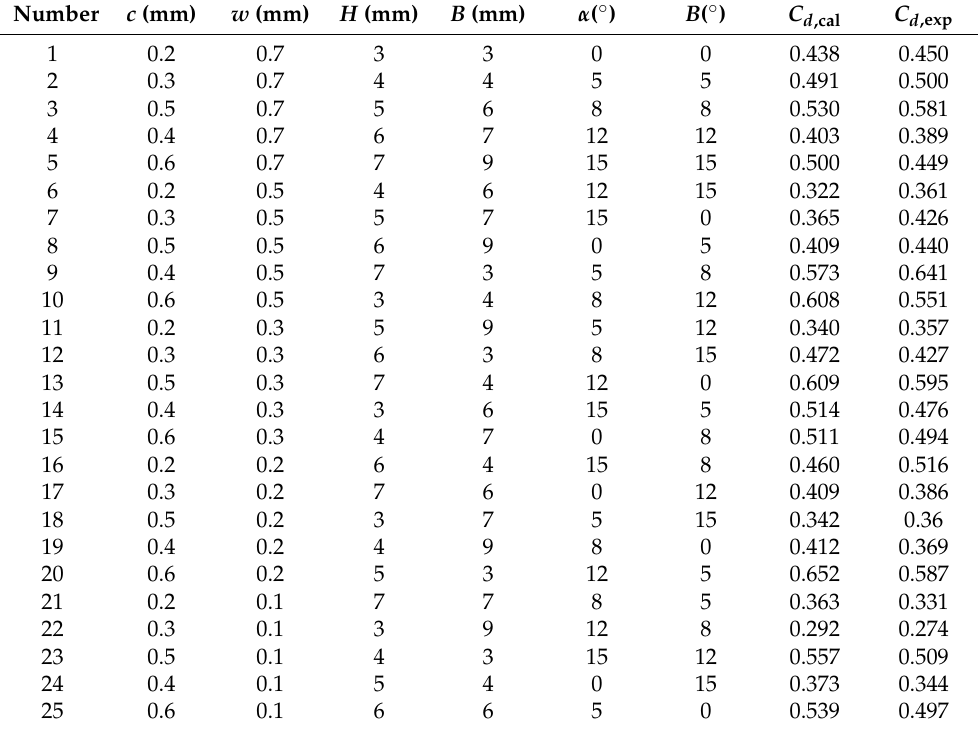
Table 2. Experimental data vs. CFD data.